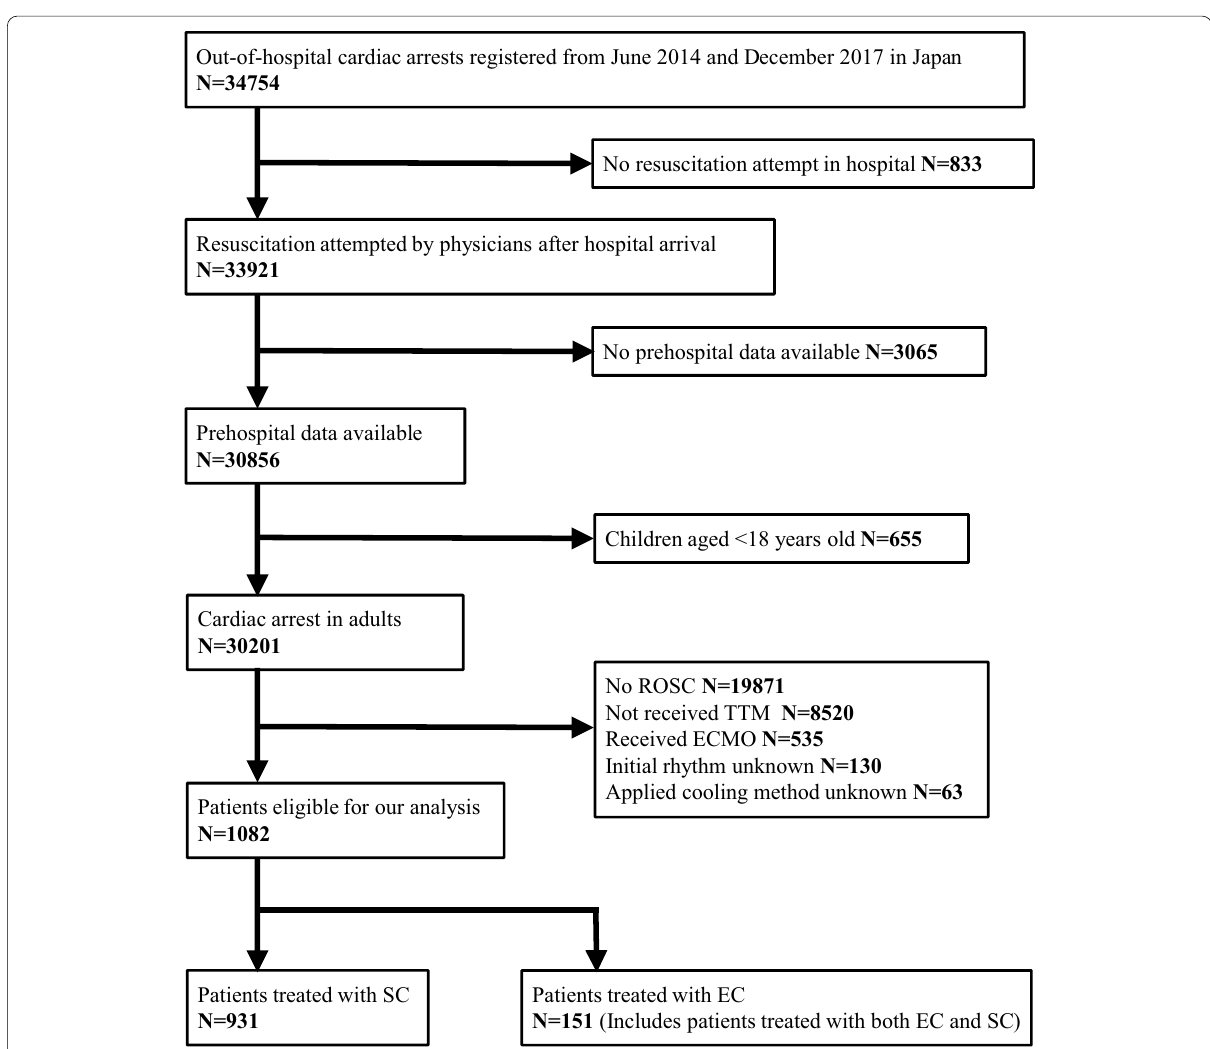
Fig. 1 Study flow chart. TTM target temperature management, ECMO extracorporeal membrane oxygenation, ROSC return of spontaneous circulation, SC surface cooling, EC endovascular